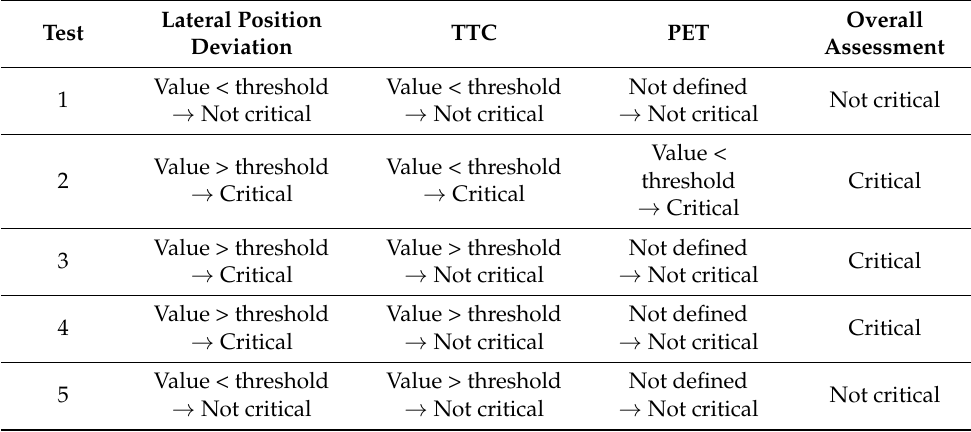
Table 2. Criticality assessment based on the used metrics in the respective